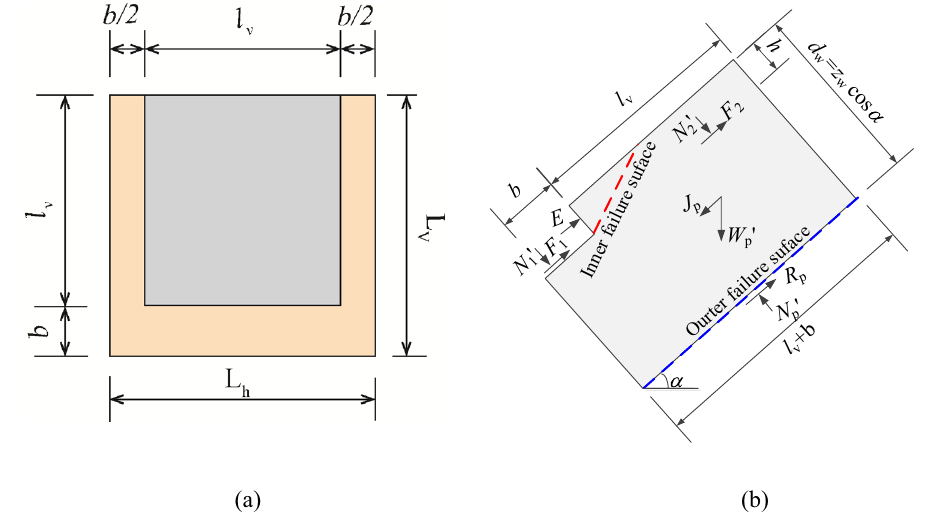
Figure 4. the protection cell and force: (a) the protection cell; (b) force on the isolated soil